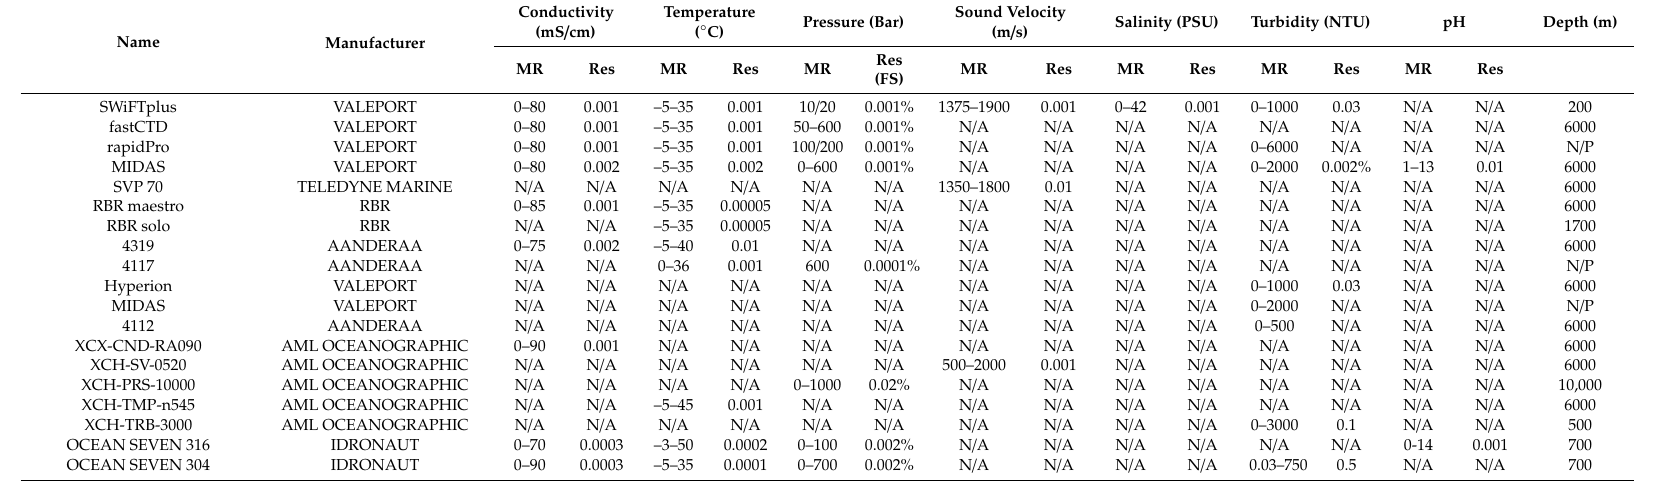
Table 22. Oceanographic sensors, MR = measuring range, Res =